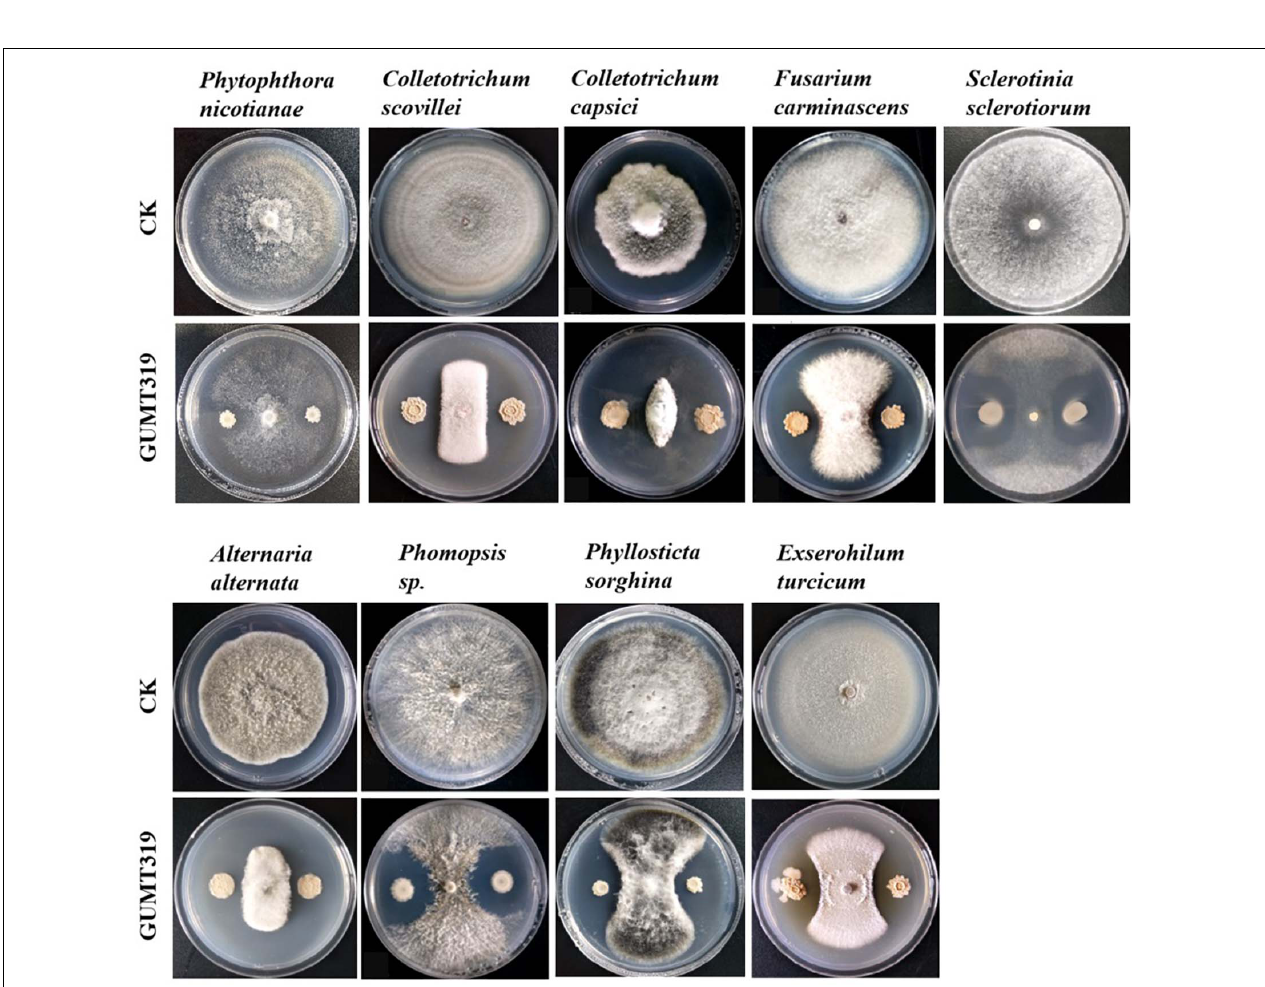
FIGURE 7 | Antagonistic activity of B. velezensis GUMT319 against nine plant pathogens in dual-culture test.